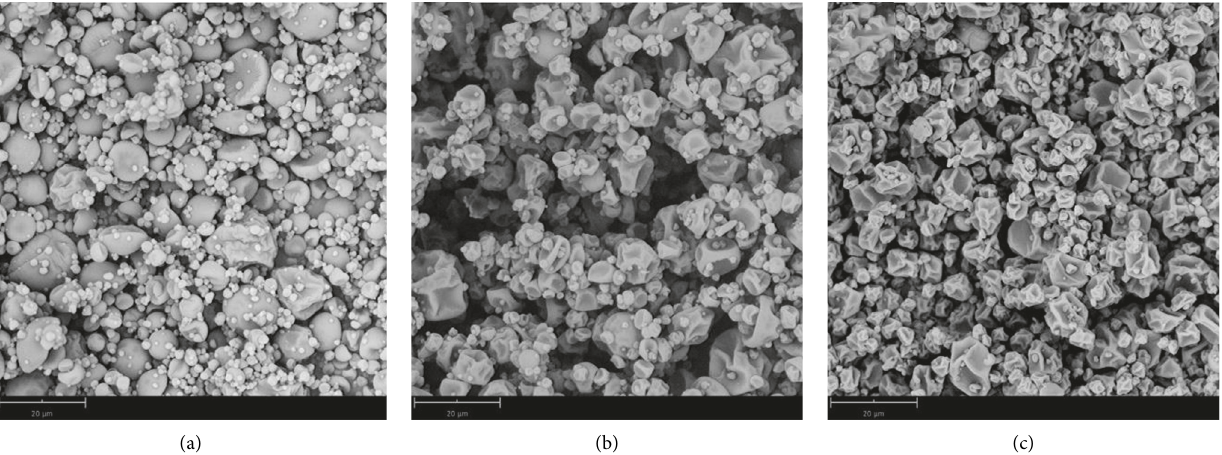
Figure 4: Microphotographs of microcapsules prepared by SEM. (a) Maltodextrin/extract, (b) Maltodextrin/Arabic gum/extract, (c) Maltodextrin/modified